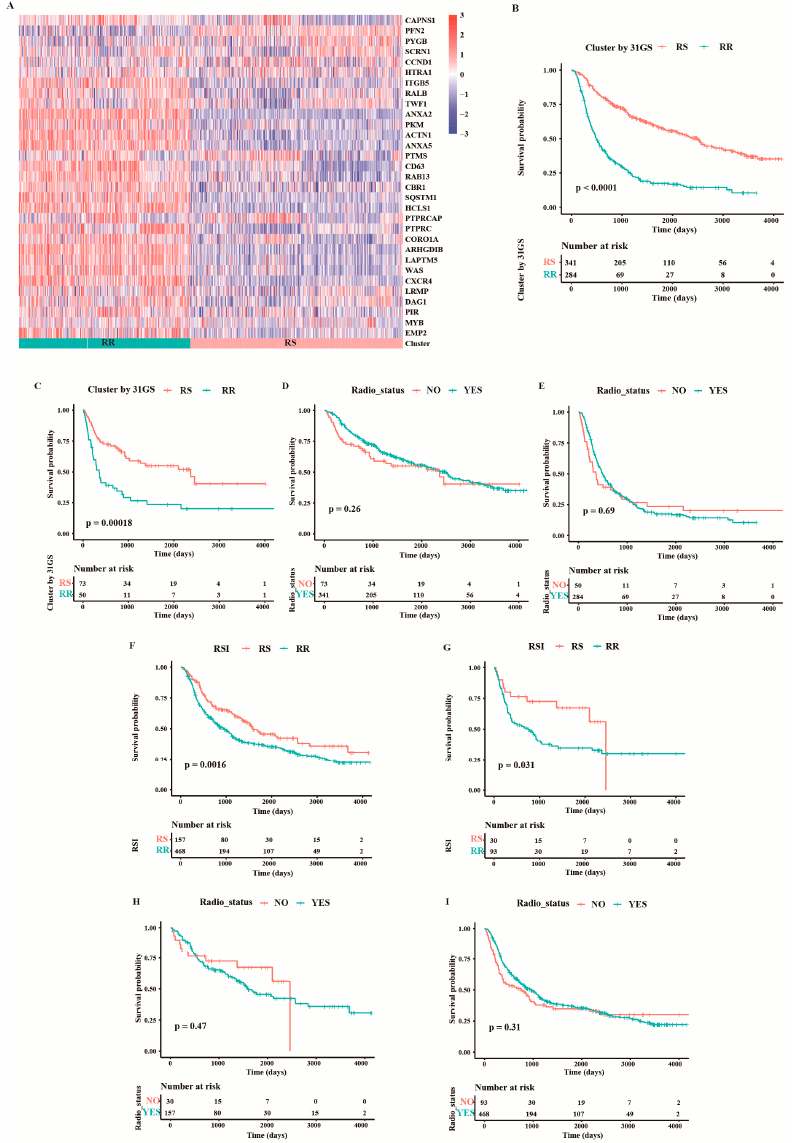
Figure 2. Validation of the two existing radiosensitivity signatures in CGGA cohort. ( A ) Heatmap illustrating the condition of 31-gene signature and radiosensitivity classification in all samples from the CGGA cohort. Survival comparison between RS group and RR group for patients treated with ( B ) and without RT ( C ) when classifying them based on 31-GS. Survival comparison between patients with and without RT in the RS group ( D ) and RR group ( E ) classified based on 31-GS. A comparison of overall survival between RS and RR group for patients treated with ( F ) and without RT ( G ) based on RSI. Comparison of overall survival between patients with and without RT in the RS group ( H ) and RR group ( I ) classified based on RSI.